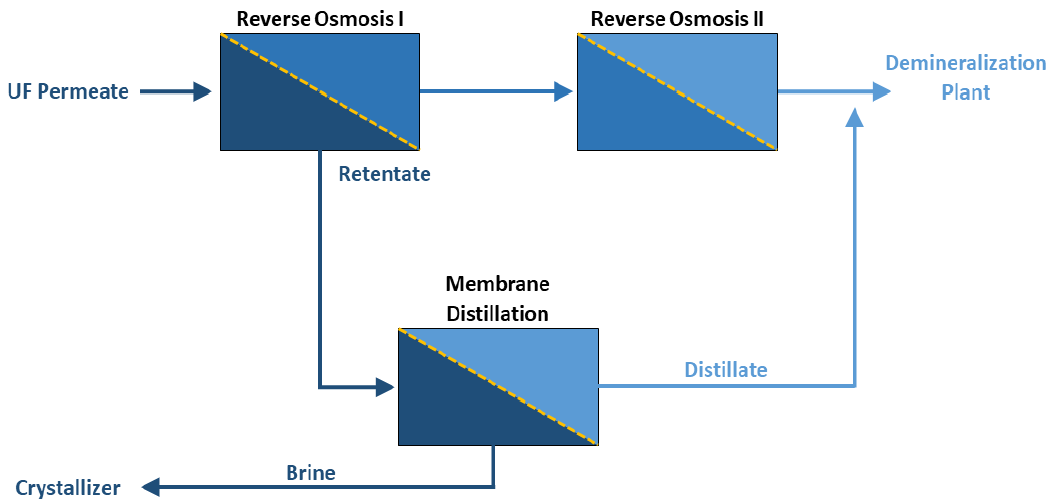
Figure A1. Water desalination by an RO + VMD integrated process. The schematic diagram shows the hybrid reverse-osmosis membrane-distillation process for maximizing the system recovery rate and minimizing the environmental impact of brine waste when a VMD unit is added downstream of the RO unit for further recovery.